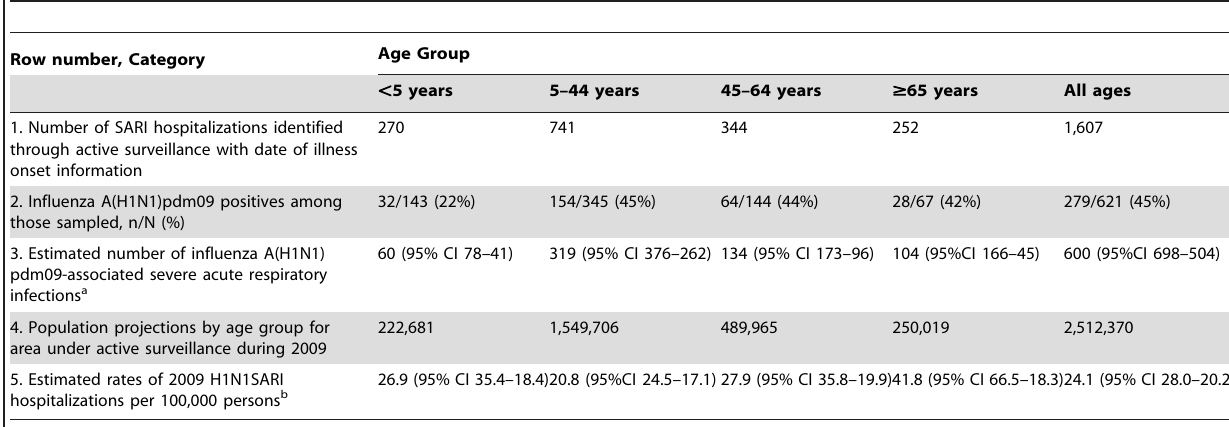
Table 2. Rates of influenza A(H1N1)pdm09-associated severe acute respiratory case-patients at three sentinel cities in Argentina, according to age group May–December, 2009.